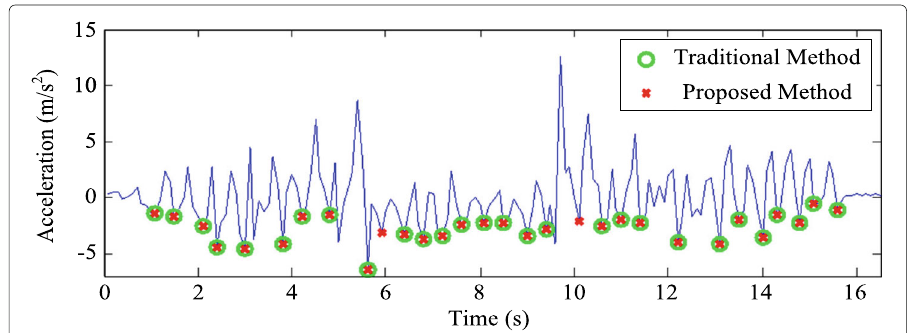
Fig. 8 Comparison between the proposed method and traditional method